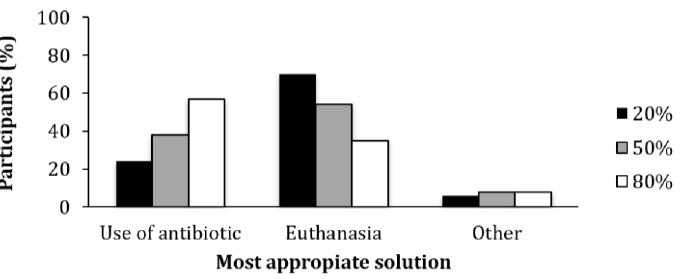
Figure 2. Percentage of participants that chose each of the given options towards the most appropriate solution for unhealthy pigs with different probabilities of recovery (20%, 50% or 80%) after treatment.